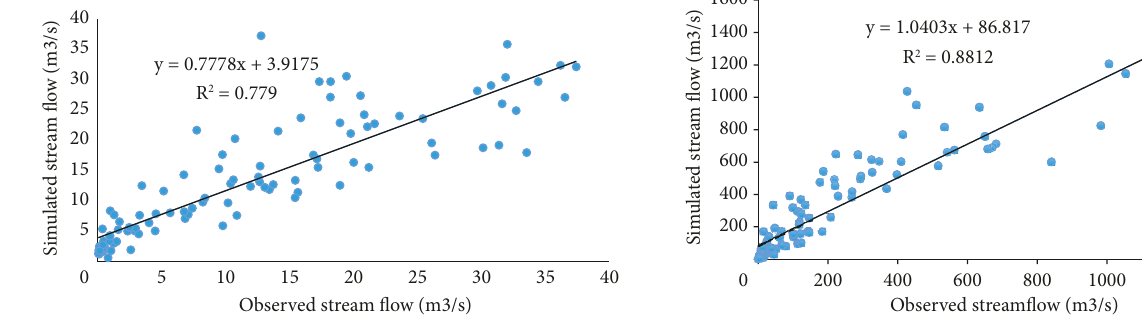
Figure 14: Scatter plots of observed and simulated monthly streamflow for the Nashe watershed during the validation